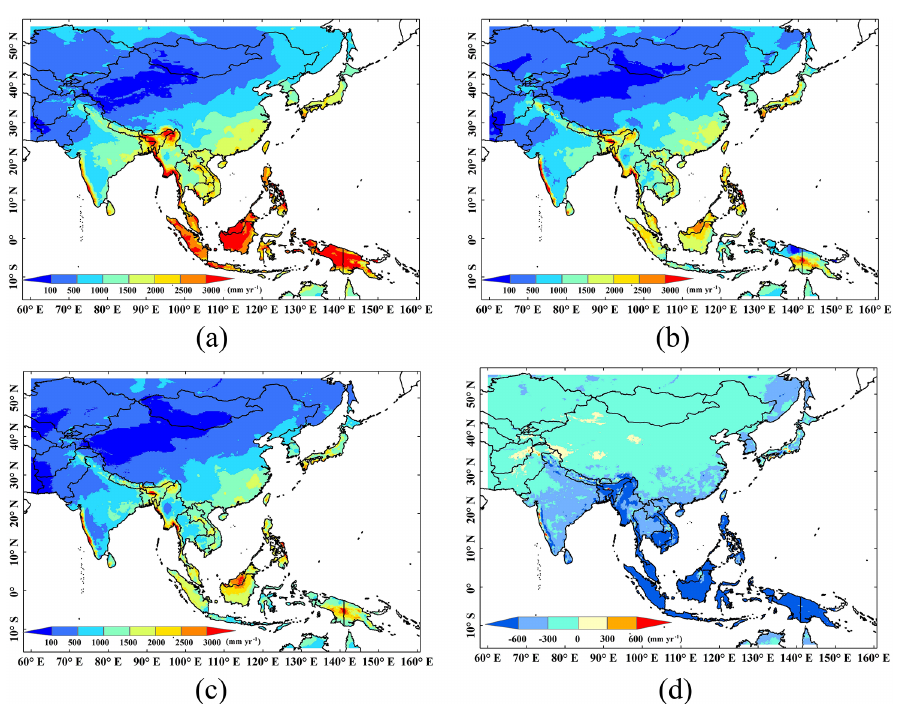
Figure 2. Spatial patterns of Asian mean annual gridded precipitation products of (a) IMERG, 0.1 ◦ ; (b) APHRODITE, 0.25 ◦ ; (c) AIMERG, 0.1 ◦ ; and (d) AIMERG-IMERG, 0.1 ◦ , during the period of 2001–2015. For visualization, the spatial maps were generated using ArcGIS 10.3 (http://www.esri.com/software/arcgis/, last access: 1 July